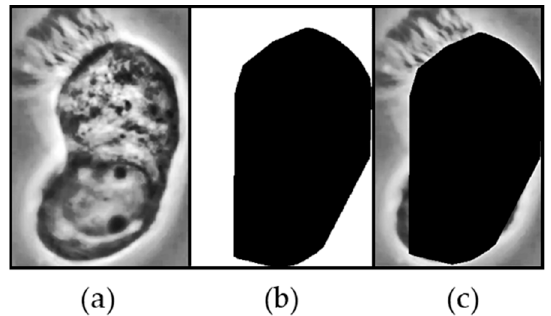
Figure 4. An example of cell body masking on ilia 2: ( a ) the cell RoI; ( b ) the cell body mask, with the outcome of the convex hull; and ( c ) the image after the cell body masking operation. In this way, beating cilia are isolated and the masked pixels are not used to compute the beating frequency.